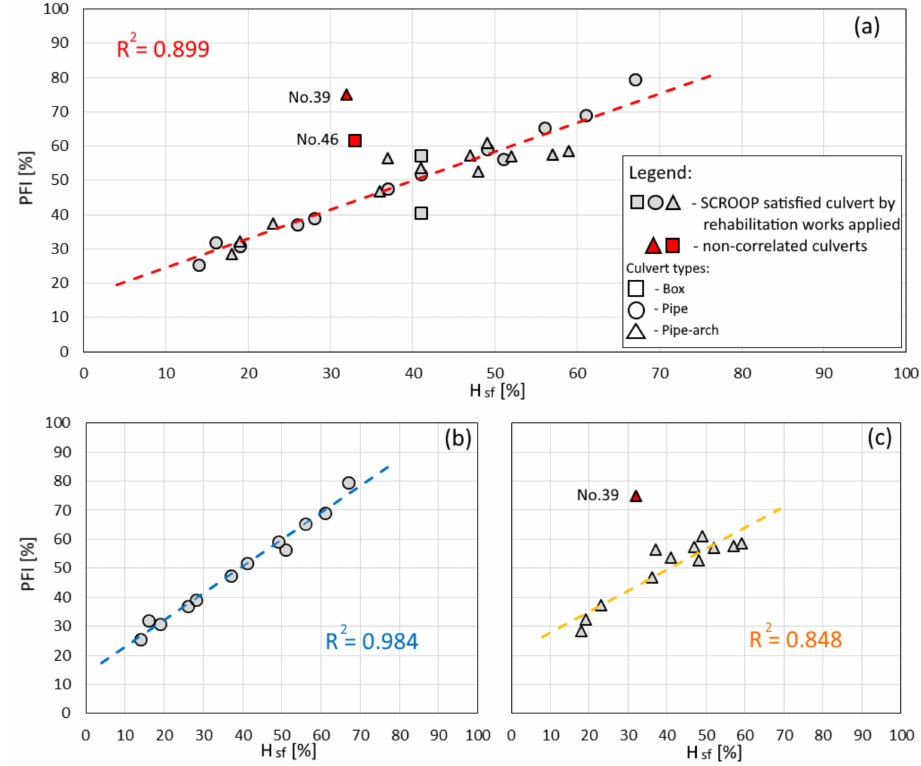
Figure 11. Correlation between H sf and PFI for culverts that satisfy SCROOP after application of rehabilitation works: ( a ) for all culverts, ( b ) for pipe culverts, and ( c ) for pipe arch